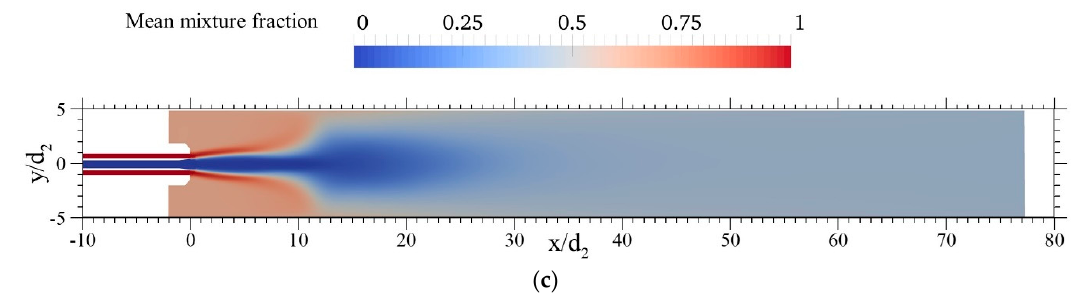
Figure 8. Longitudinal slices of time-averaged fields: ( a ) static temperature; ( b ) velocity magnitude; ( c ) mixture fraction ( Sc t = 0.7). Coordinates of computational domain are non-dimensionalized by diameter of circular oxidizer pipe at exit ( d 2 ).